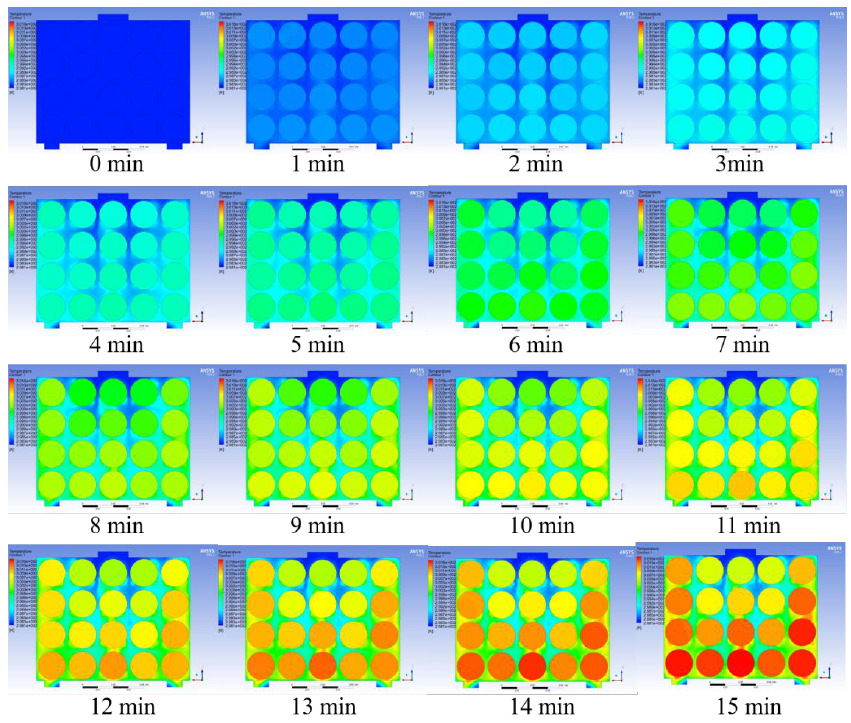
Figure 24. A temperature field change in scheme 13 in the dying minutes.